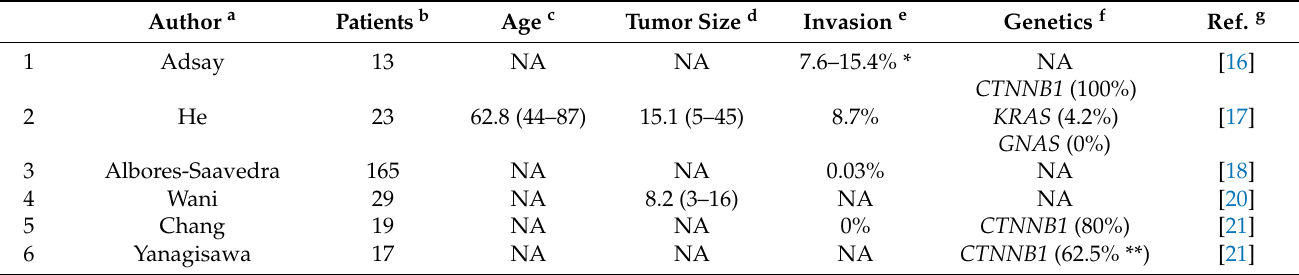
Table 1. Studies on pathology of pyloric gland adenoma (PGA) of the